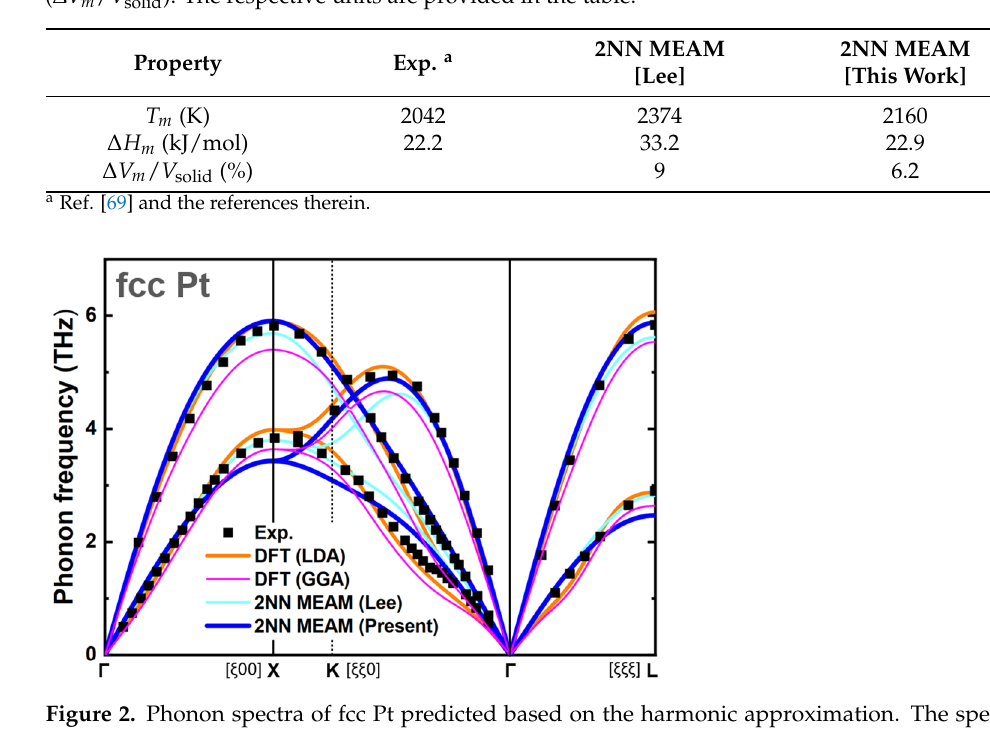
Table 4. Thermal properties associated with the melting of pure Pt obtained from the experiment, previous [69] and present interatomic 2NN MEAM interatomic potential. The target properties are the melting temperature ( T m ), enthalpy of melting ( ∆ H m ), and volume change upon melting ( ∆ V m / V solid ). The respective units are provided in the table.